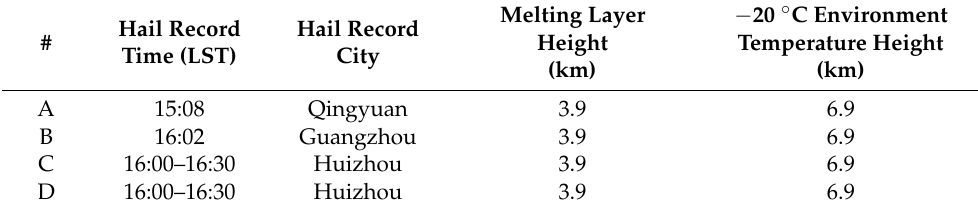
Table 3. Ground hail records and sounding records of Hailstorm